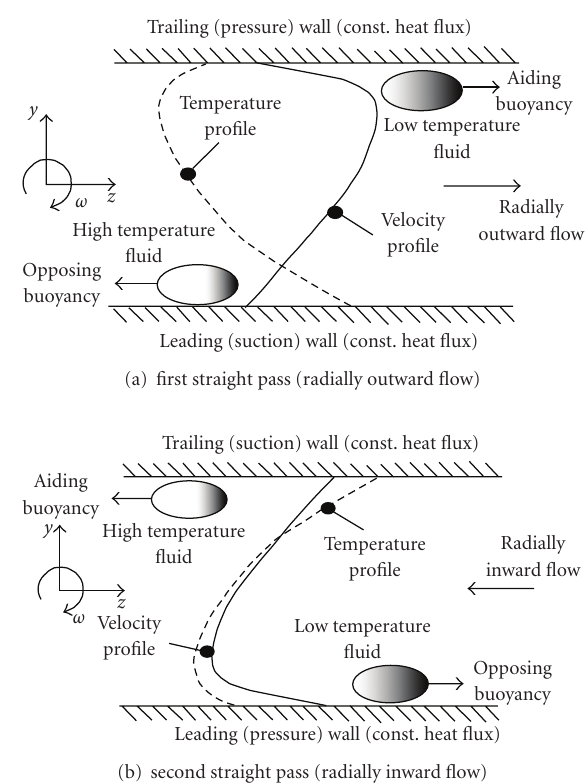
Figure 5: Explanation of aiding and opposing buoyancy contribu- tions in first (radially outward flow) and second (radially inward flow) straight